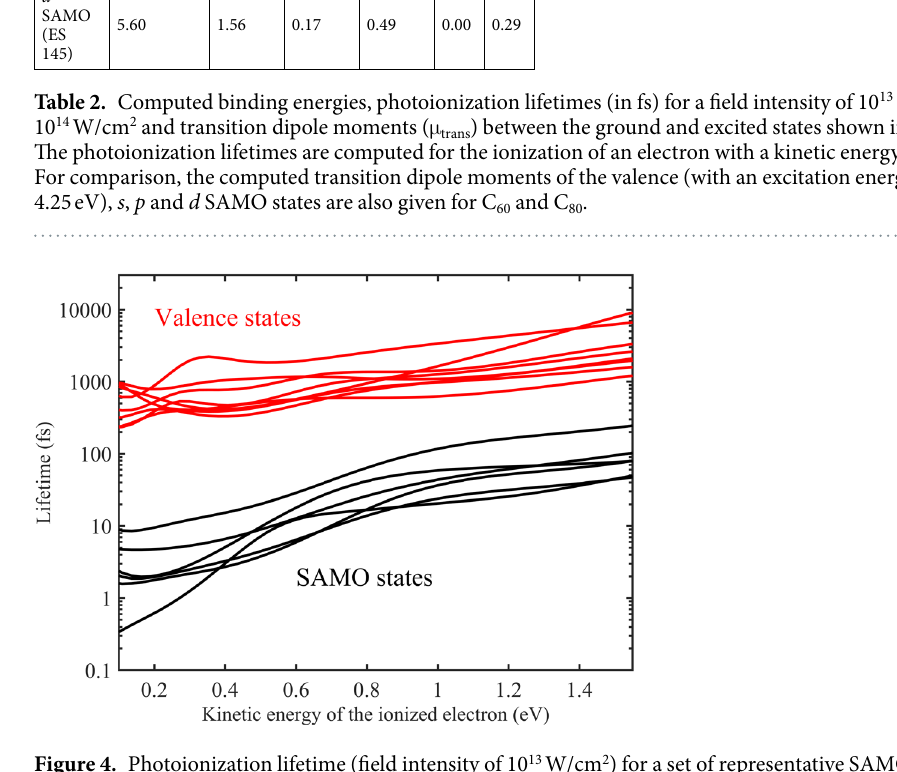
Figure 4. Photoionization lifetime (field intensity of 10 13 W/cm 2 ) for a set of representative SAMO and valence states, plotted as a function of the kinetic energy of electron ionized from the SAMO or valence states. Amongst the valence states, some are isoenergetic with the SAMO states (see S.I. for